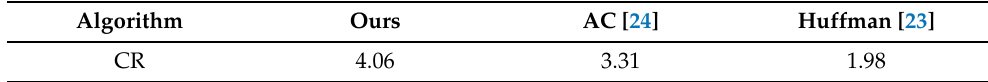
Table 3. Comparison of different compression algorithms (avg).